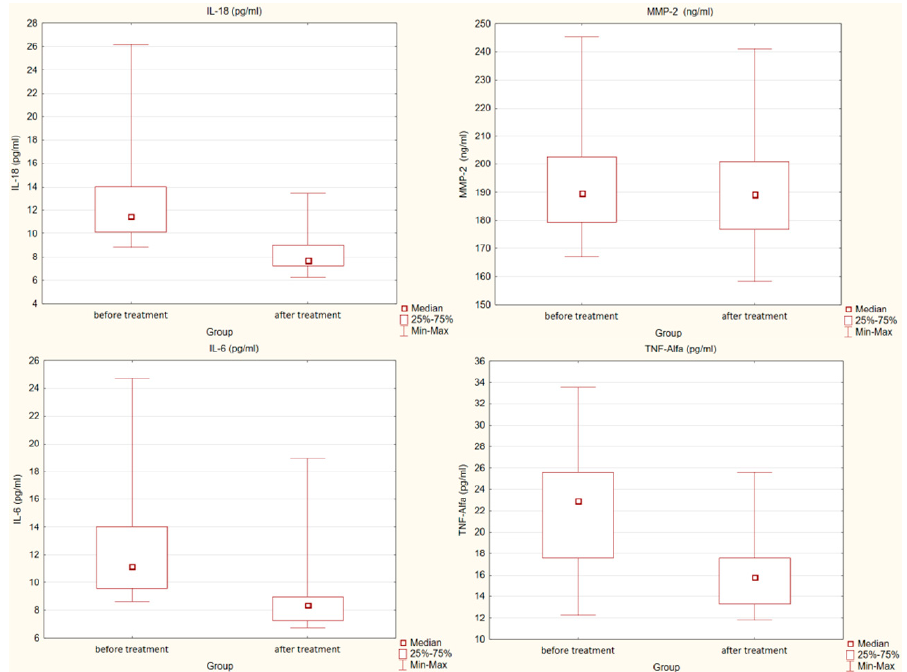
Figure 2. Differences in concentration of interleukin 18 (IL-18), interleukin 6 (IL-6), tumor necrosis factor α (TNF- α ) ( p < 0.001) and metalloproteinase 2 (MMP-2) ( p < 0.05) in the study group before and after treatment.